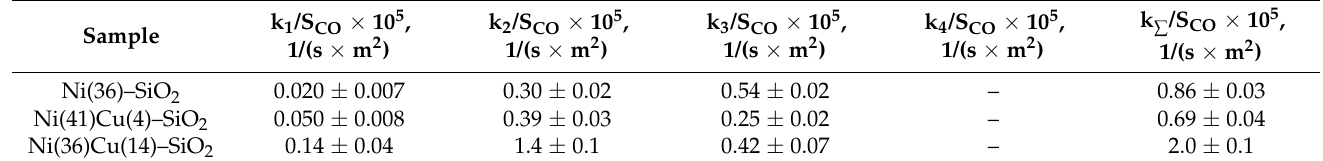
Table 5. Specific catalytic activity of the catalysts in TH of anisole at 150 ◦